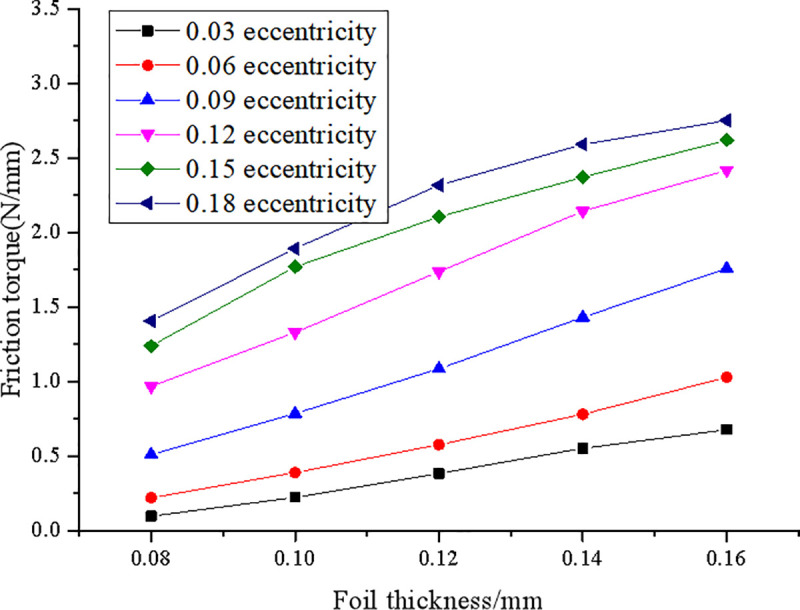
The influence of foil thickness on the friction torque of hybrid bearing system under different eccentricities.